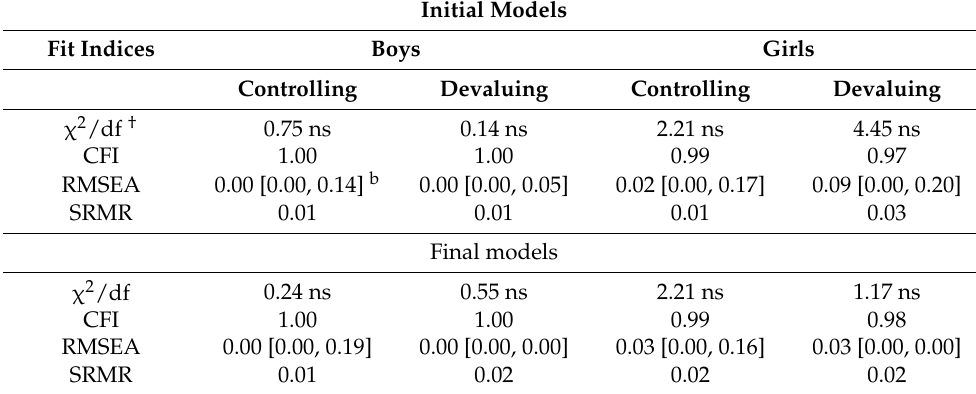
Table 3. Fit indices of the initial and final models in the study with adolescents in dating relationships.